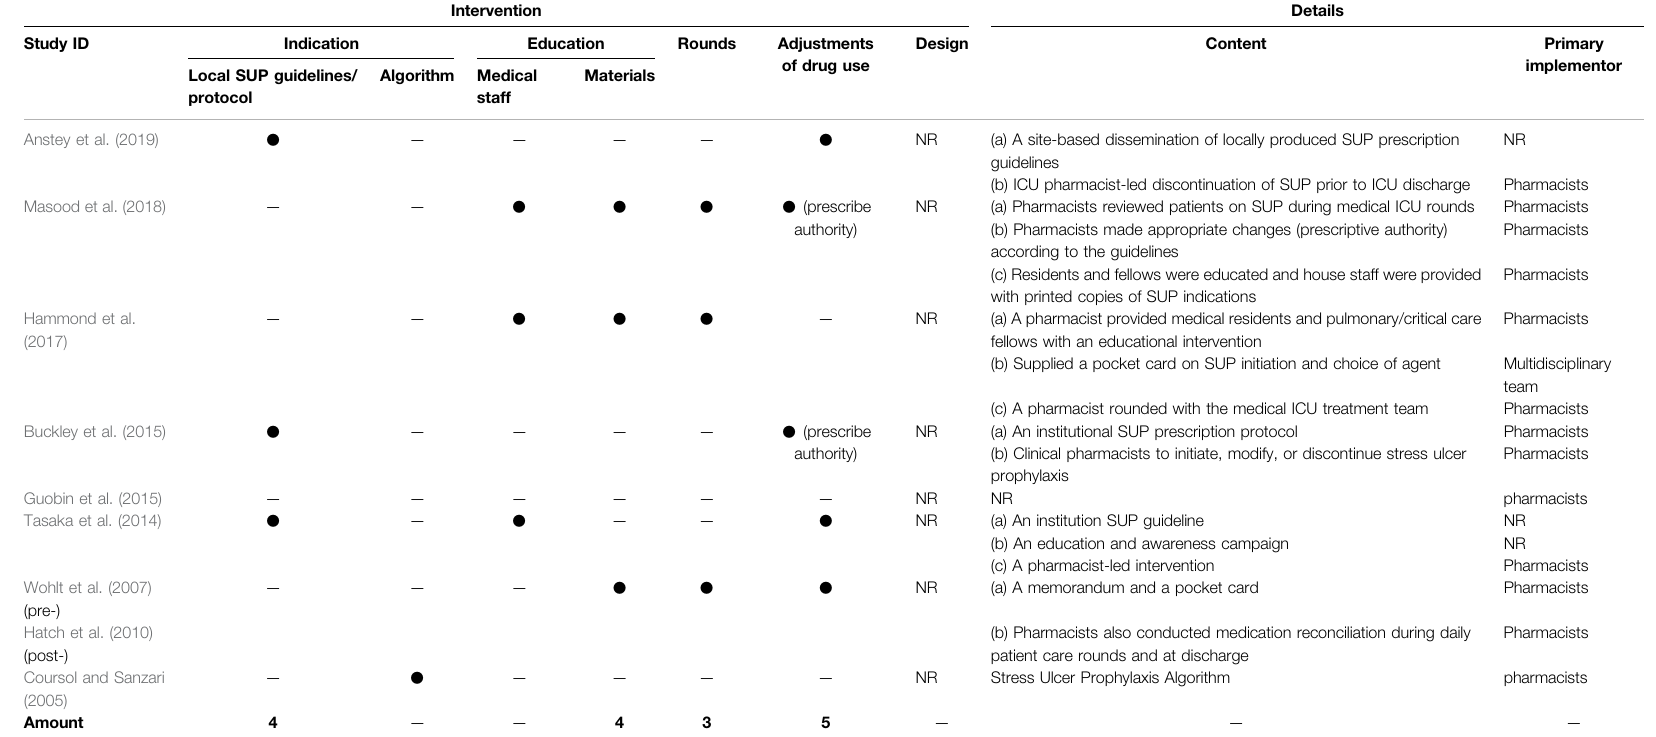
TABLE 4 | Intervention content and delivery of included